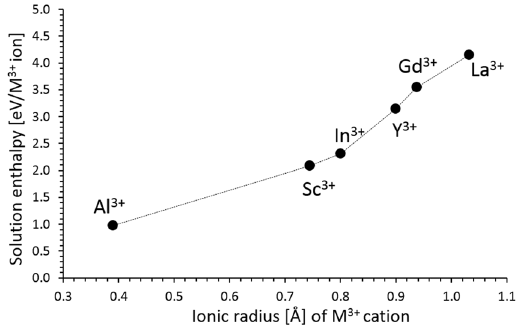
Figure 3. Enthalpy of solution of R O